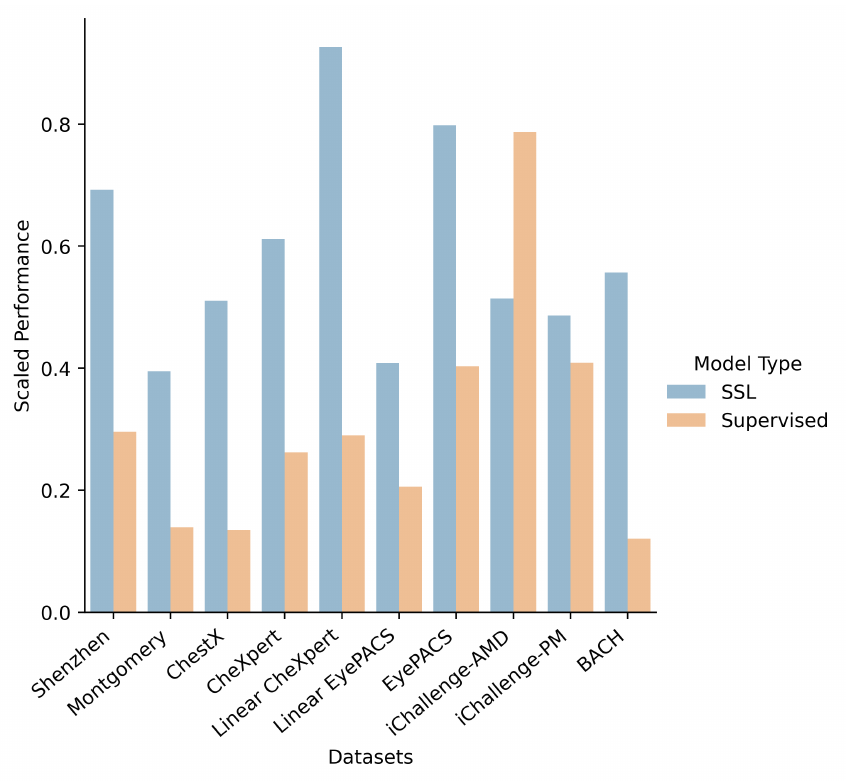
Figure 2. Bar chart of model transfer performance on different downstream tasks. SSL (blue) refers to the average over the self-supervised models (SimCLR, MoCo, SwAV, BYOL, PIRL) and Supervised (orange) refers to the average of the supervised models (ResNet-50, ResNet-18, DenseNet-121). For each downstream task, all results are scaled between 0 and 1 (across the SSL and Supervised models - not including the domain-specific models).